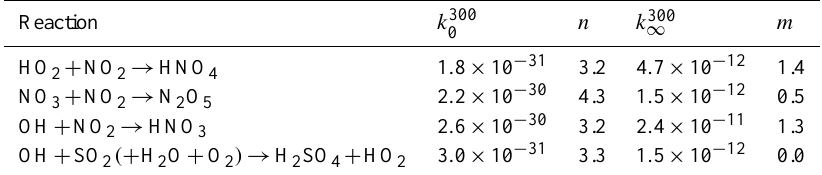
− 1 (T/ 300 ) − n and , where k 0 (T ) = k 300 0